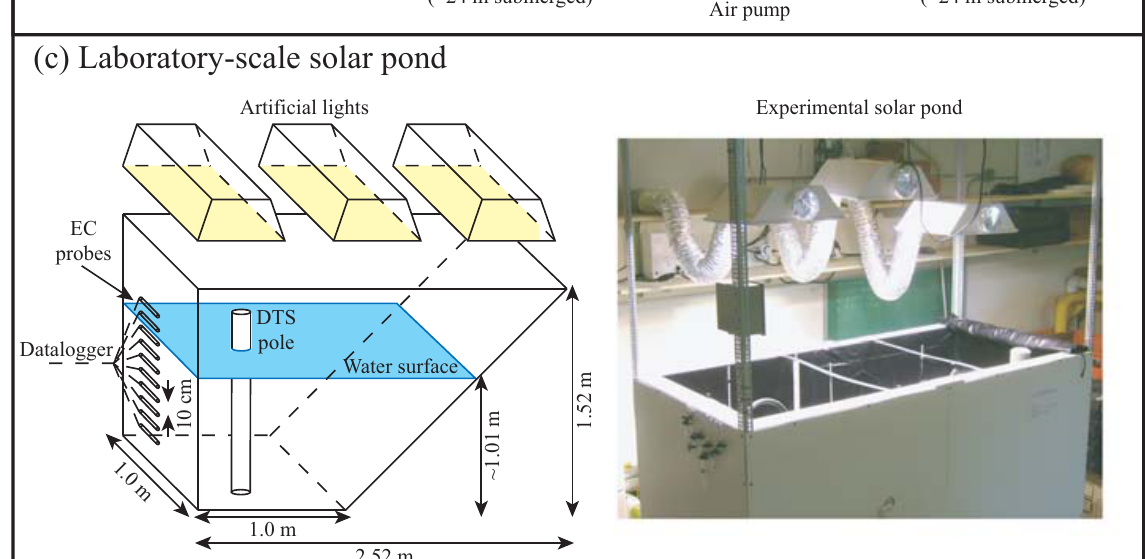
Fig. 1. Diagrams of the (a) DTS pole, (b) DTS installation, and (c) experimental solar pond.